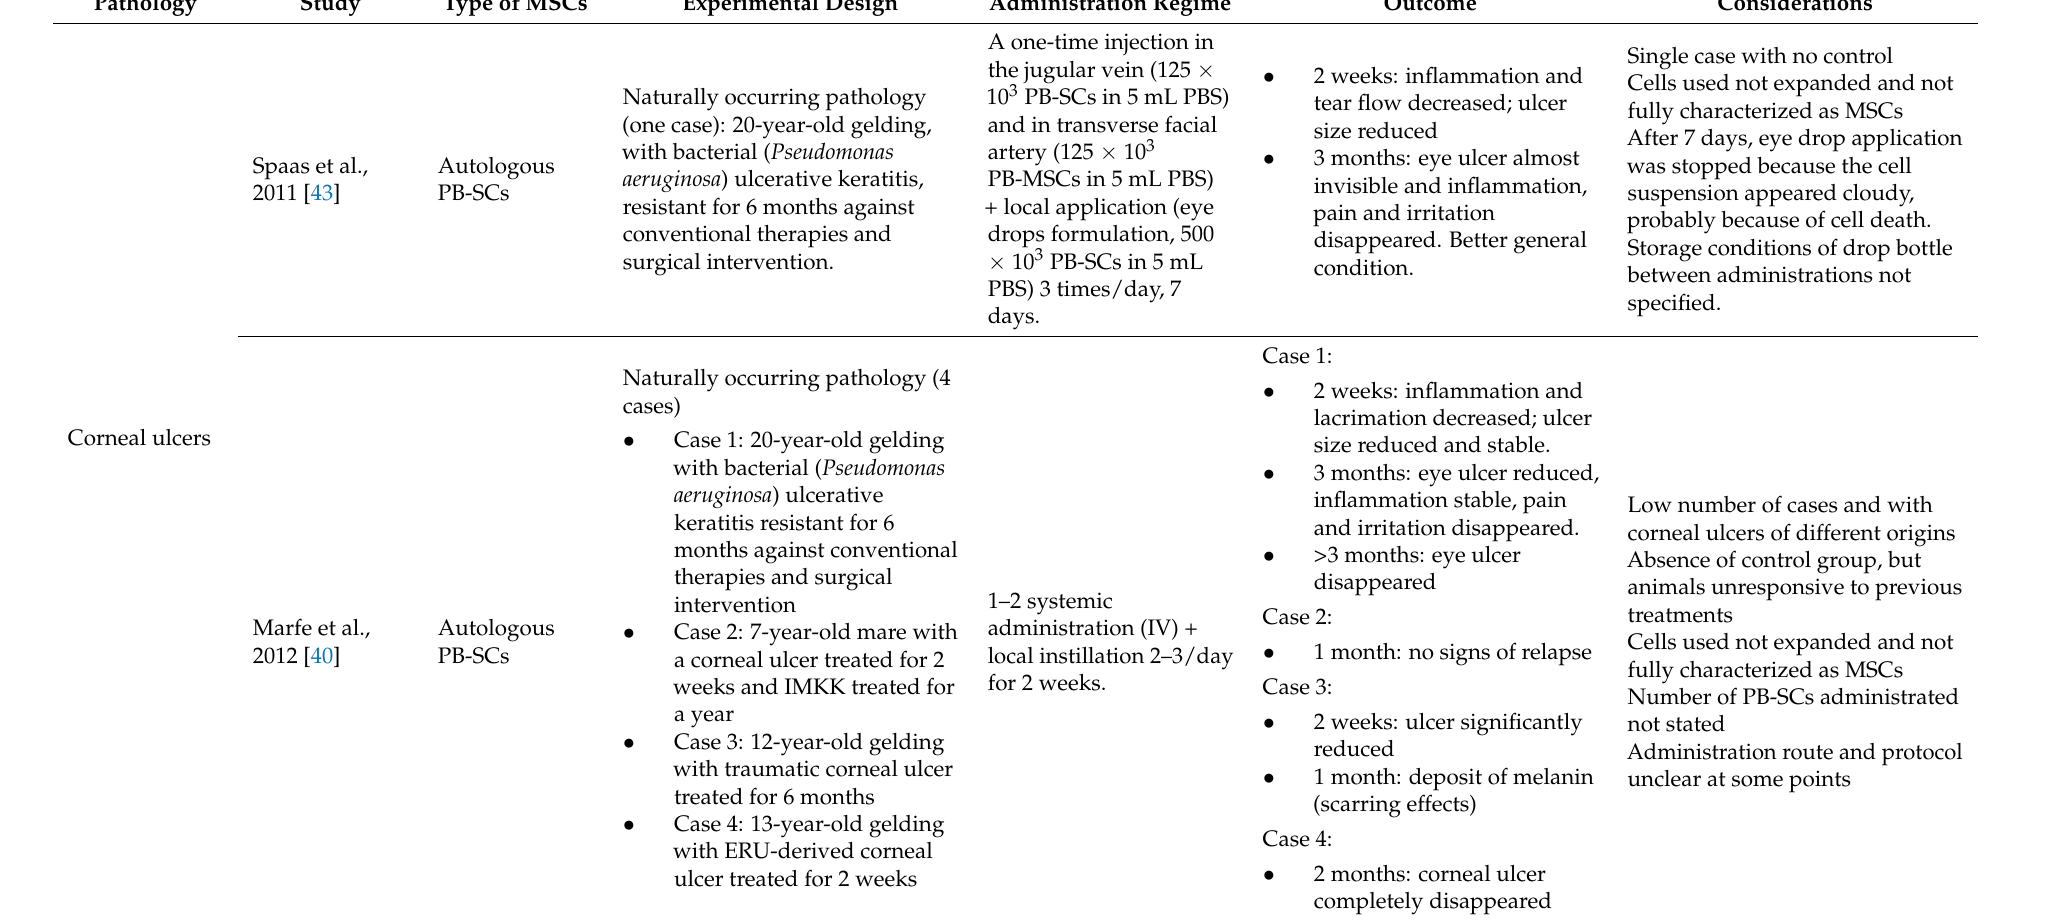
Table 1. Ophthalmology in vivo studies using stem cells in horses. Peripheral blood stem cells (PB-SCs), phosphate-buffered saline (PBS), equine recurrent uveitis (ERU), bone marrow-derived mesenchymal stem cells (BM-MSCs), immune-mediated keratitis (IMMK), intravenous (IV). Pathology Study